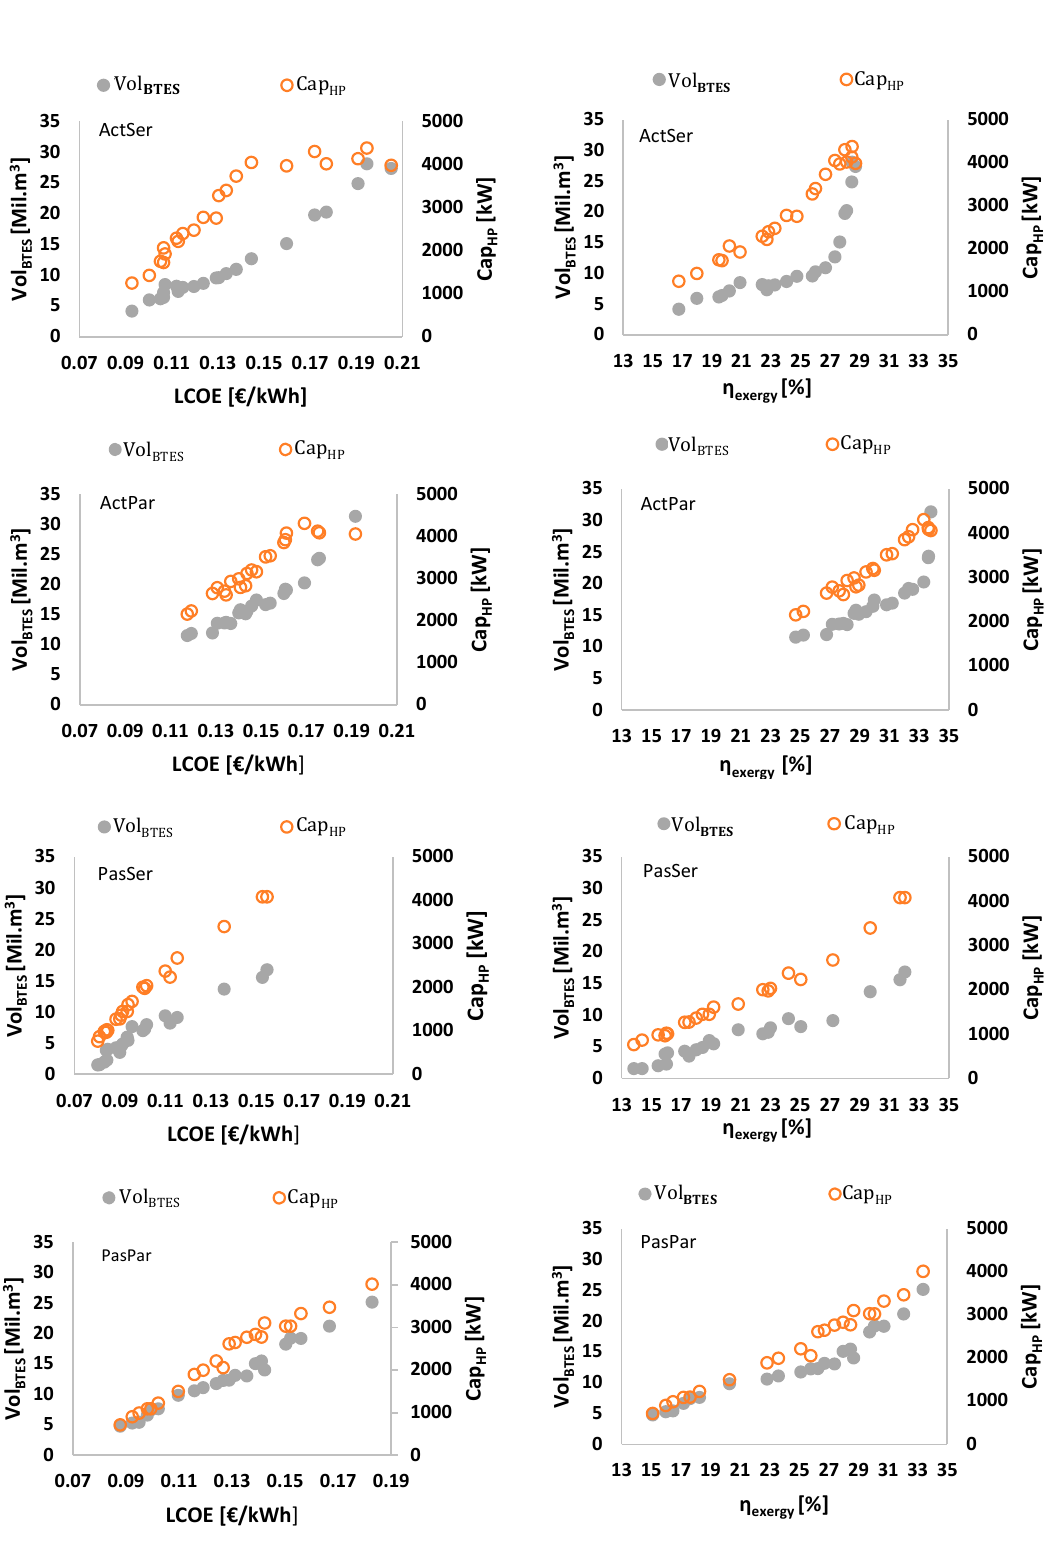
Figure 10. Scattering of the decision variables on the Pareto fronts of ActSer, ActPar, PasSer and PasPar scenarios.